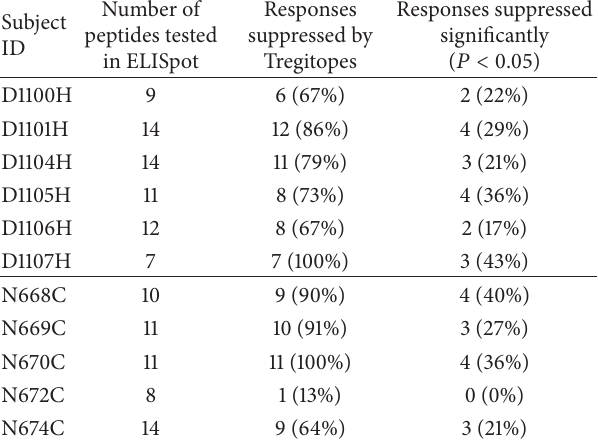
Table 4: Summary of responses of diabetic subjects to Tregitopes in vitro.EffectsofTregitopesonELISpotresponsestothepanelGAD65 epitopes,asreportedindetailinTable 3,aresummarizedhere.Inthe two-step T cell assays, IFN 𝛾 ELISpot responses to GAD65 peptides were suppressed for 78% of the peptides tested using diabetic subject PBMC and for 74% of the peptides tested using normal control subjects. The suppression reached statistical significance for more than a quarter (26%) of all assays performed.